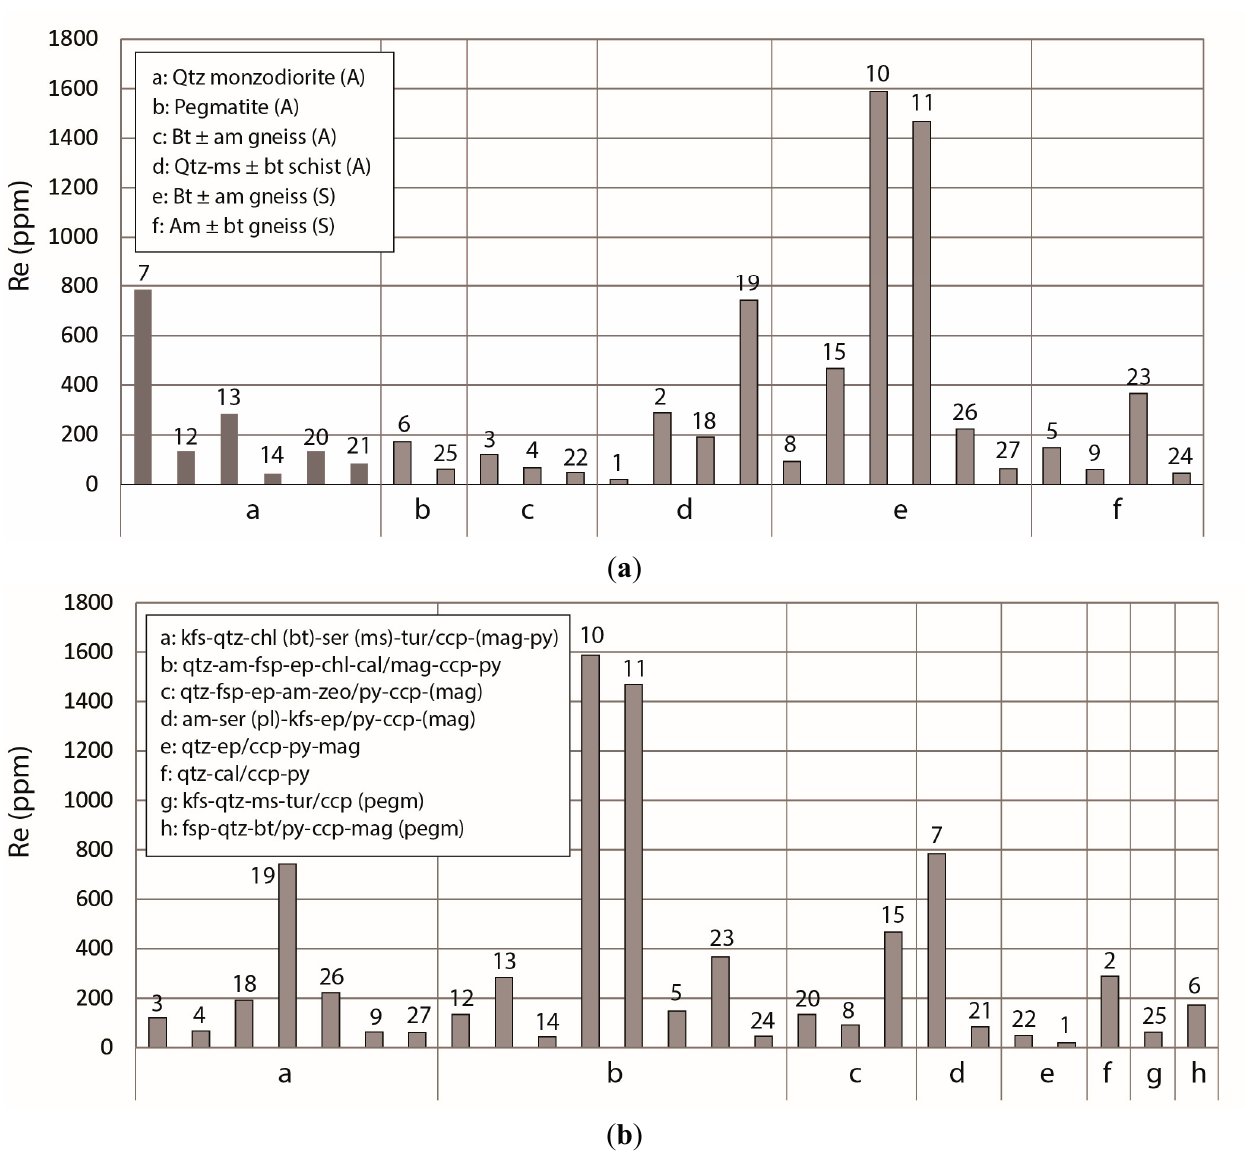
Figure 6. Rhenium concentrations within Aitik (A) and Salmijärvi (S) molybdenite grains. Sample numbers are given at the top of each bar; ( a ) Rhenium concentration of molybdenite versus molybdenite-bearing host rock; ( b ) Rhenium concentration of molybdenite versus associated alteration- and ore mineral assemblage. Abbreviations: qtz-quartz, bt-biotite, am-amphibole, ms-muscovite, kfs-K feldspar,